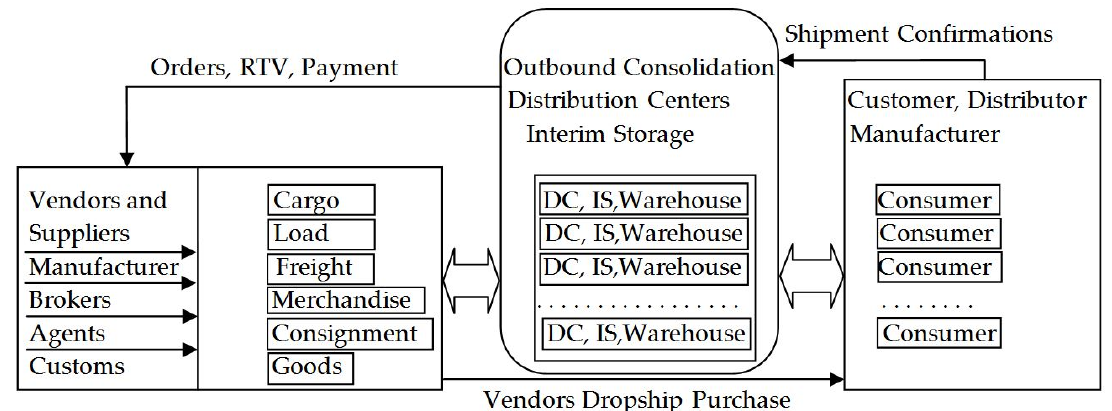
Figure 1. Schematic diagram of a traditional logistics network (DC—distribution center; RTV—return to vendor; IS—interim storage).